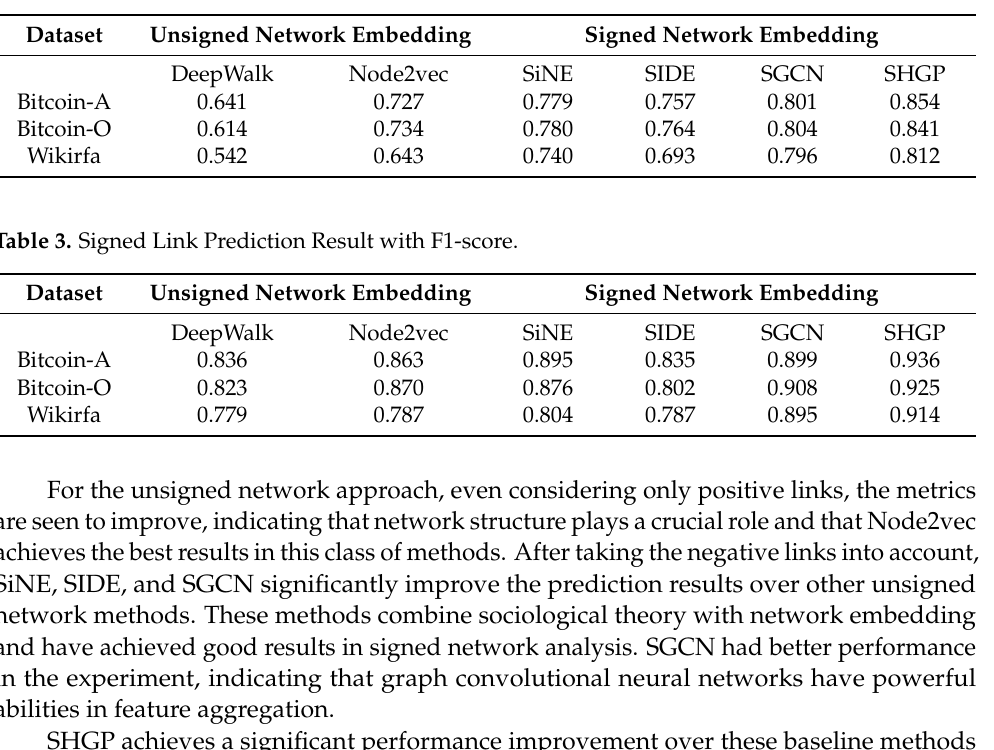
Table 2. Signed Link Prediction Result With AUC.